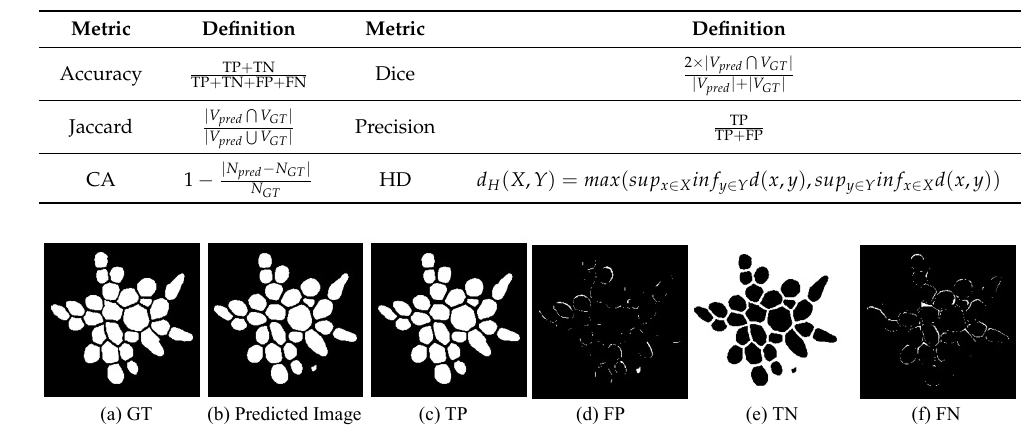
Figure 7. The illustration of TP, TN, FP and FN between the predicted image and GT